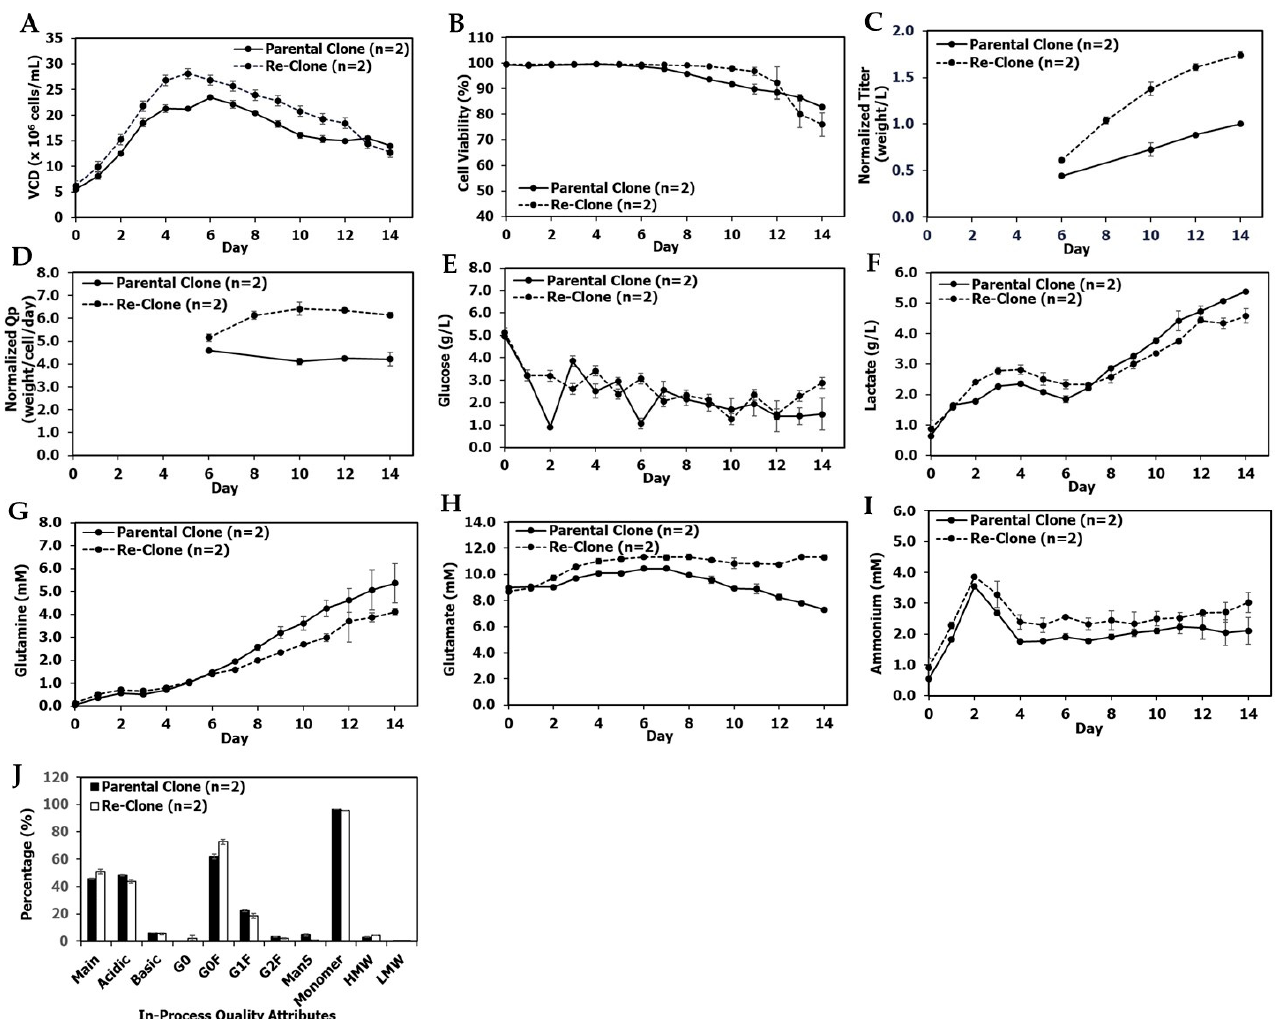
Figure 3. mAb1 production 5L bioreactor culture performance, metabolite and quality attribute profiles between the parental and re-clone. ( A ) Production 5-L bioreactor VCD, ( B ) production viability, ( C ) normalized titer, ( D ) normalized Qp, ( E ) production glucose profiles, ( F ) production lactate profiles, ( G ) production glutamine profiles, ( H ) production glutamate profiles, ( I ) production ammonium profiles, ( J ) in-process quality attribute profiles on day 14 at harvest. The parental clone G0 data was not available, and the day 14 titer was normalized as 1. The values are reported as average ± difference/2 ( n =